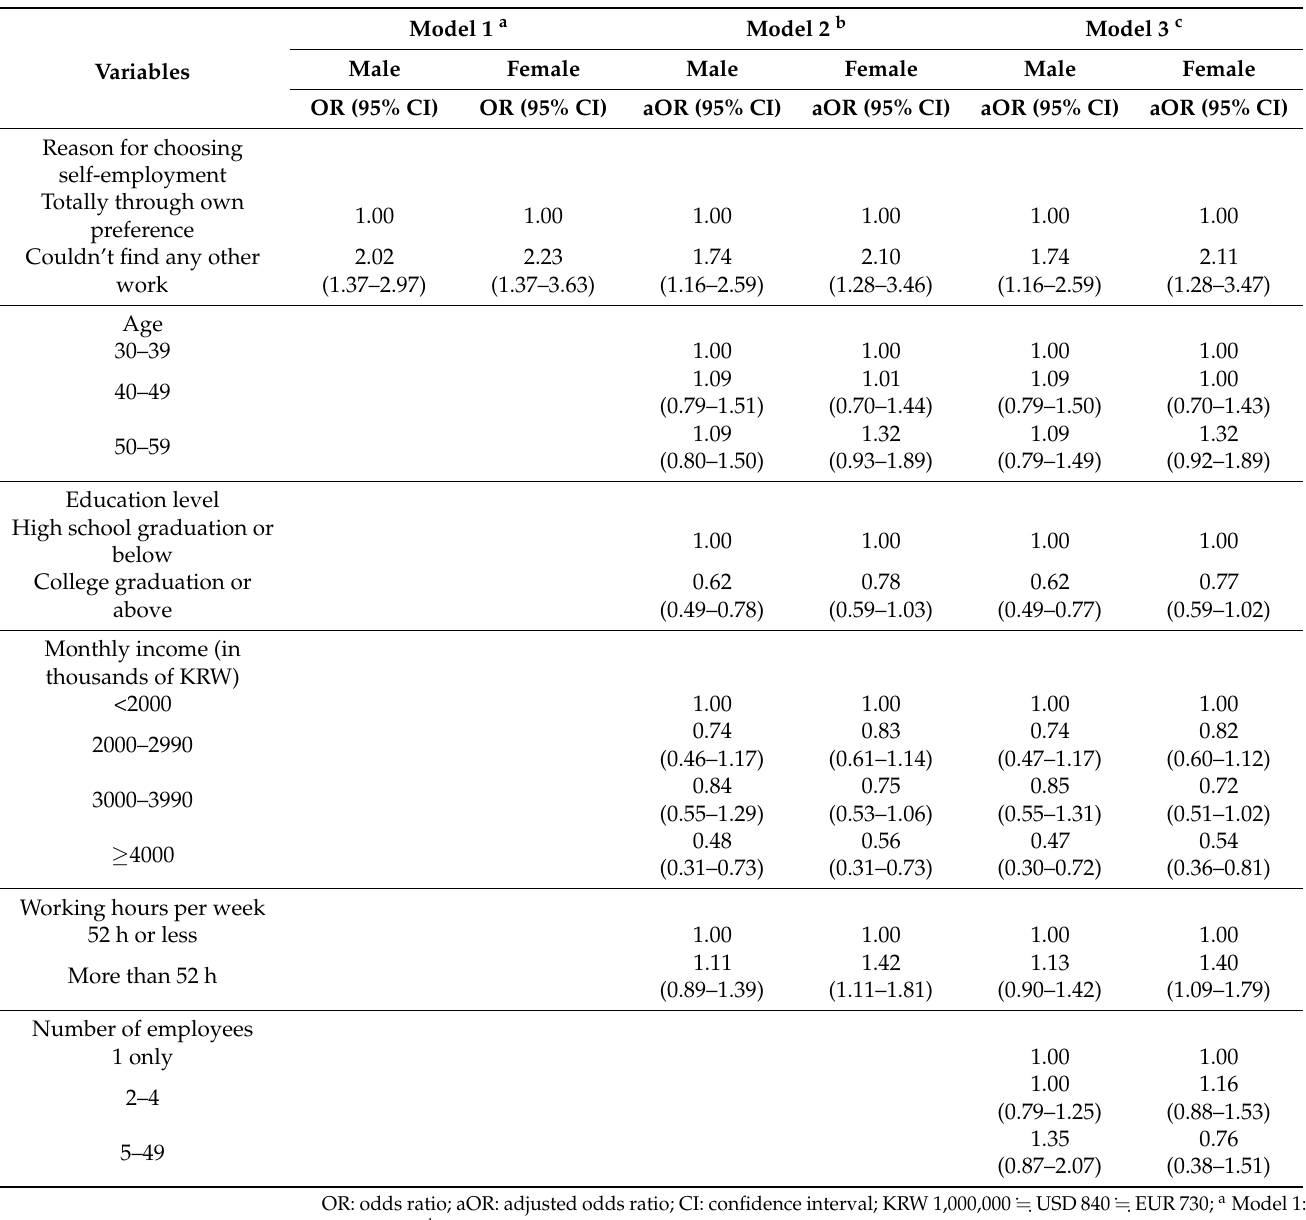
Table 3. Adjusted odds ratios for the poor well-being score groups after adjusting for